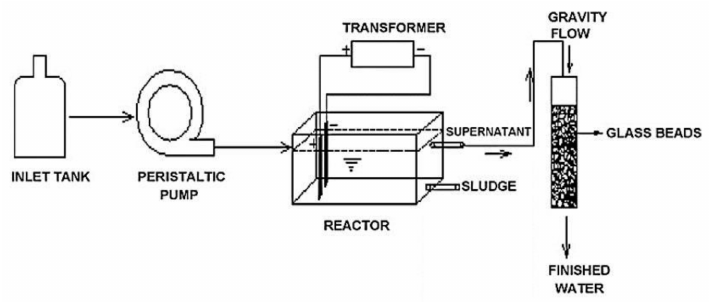
Figure 14. Experimental set-up diagram